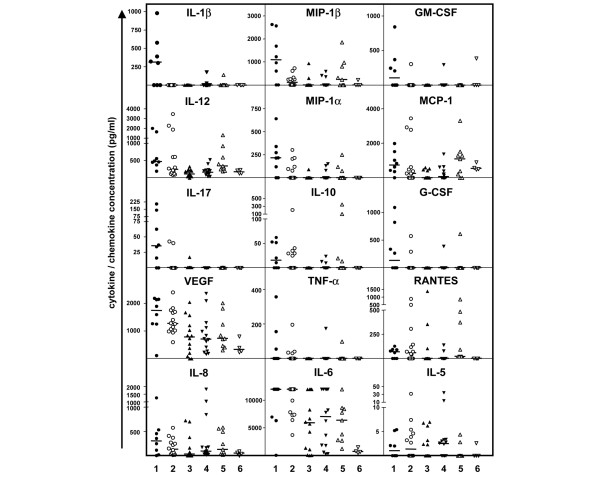
Synovial fluid cytokines in early and established arthritis. Shown are synovial fluid concentrations (pg/ml) of IL-1β, macrophage inflammatory protein (MIP)-1β, granulocyte–macrophage colony-stimulating factor (GM-CSF), IL-12, MIP-1α, monocyte chemoattractant protein (MCP)-1, IL-17, IL-10, granulocyte colony-stimulating factor (G-CSF), vascular endothelial growth factor (VEGF), tumour necrosis factor (TNF)-α, RANTES (regulated on activation, normal T expressed and secreted), IL-8, IL-6 and IL-5. Patient groups: 1, early synovitis that develops into rheumatoid arthritis (RA); 2, early synovitis that develops into non-rheumatoid persistent synovitis; 3, early non-crystal-related resolving synovitis; 4, crystal-related resolving synovitis; 5, established RA; and 6, osteoarthritis.